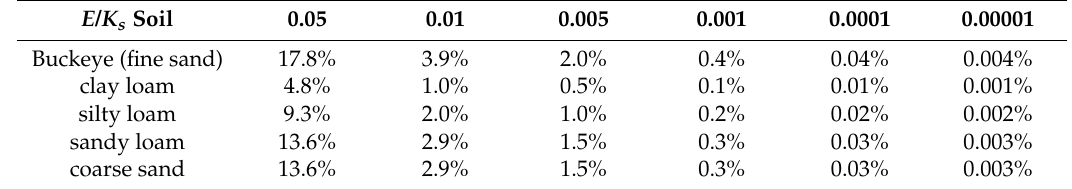
Table 3. The discrepancy ratio ( ε = | E 11 − E 12 | / E 11 ) of results calculated from Equations (11) and (12). E / K s